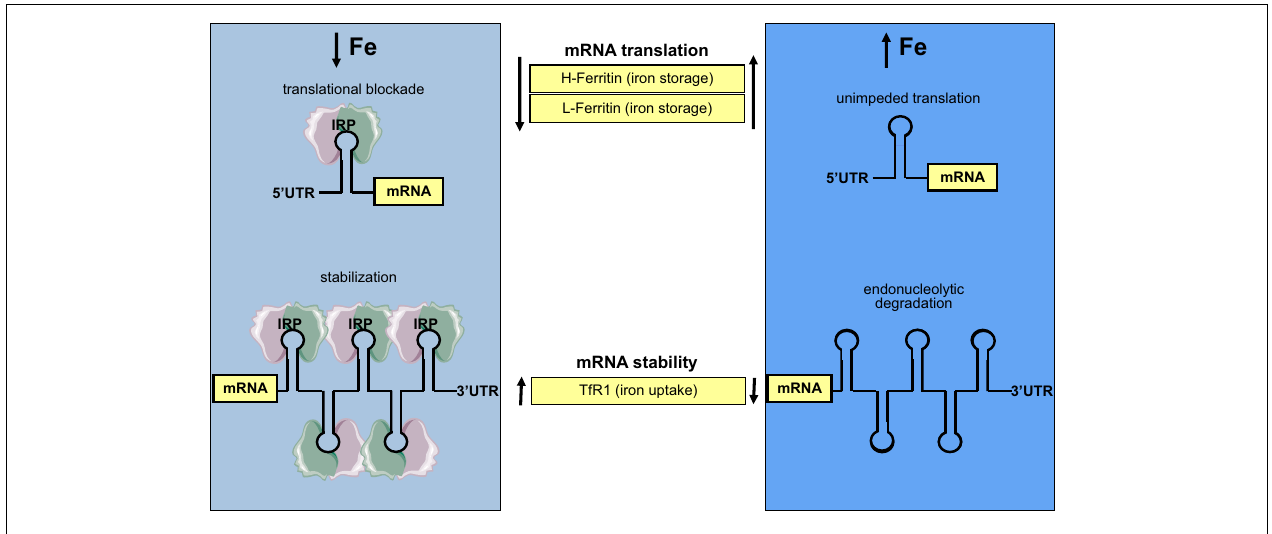
FIGURE 4 | Coordinate iron-dependent regulation of ferritin and TfR1 mRNA expression by IRE/IRP interactions. Iron deficiency promotes the binding of IRPs to cognate IREs in the untranslated regions of ferritin and